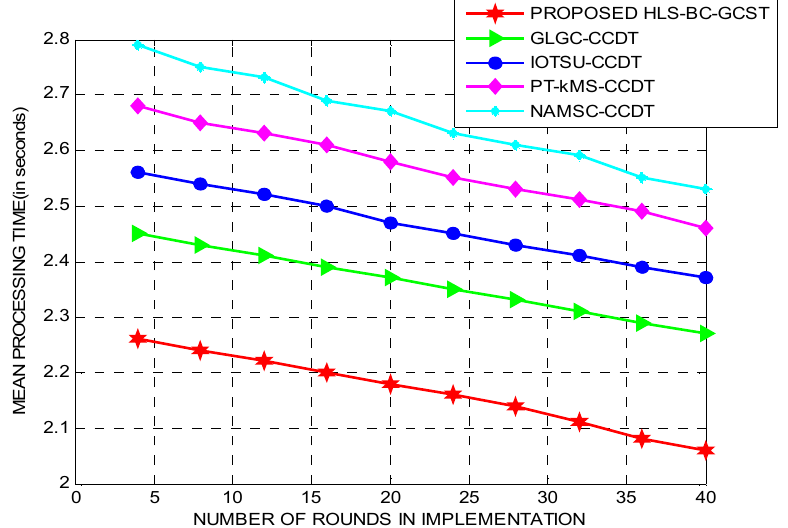
Figure 7. The proposed HLC-BC-GCST scheme evaluated using mean processing time.